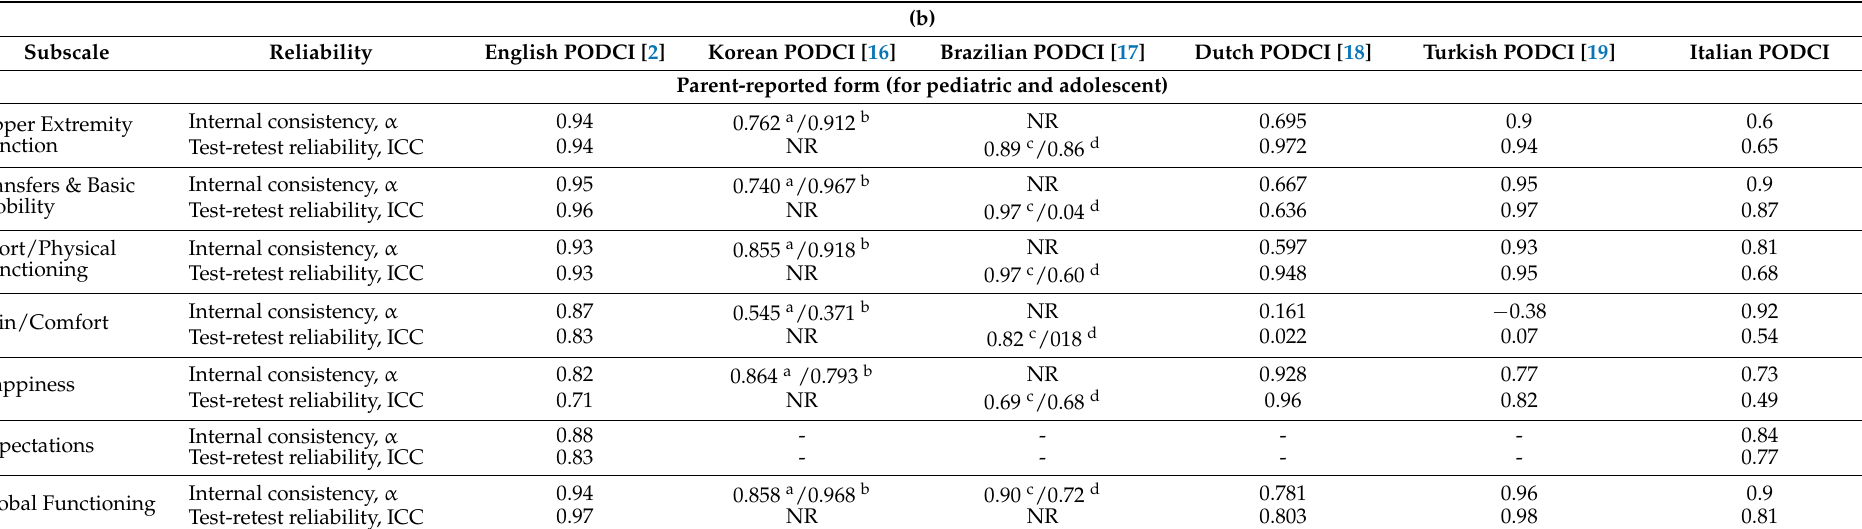
Table 1. Patient demographics and clinical characteristics.